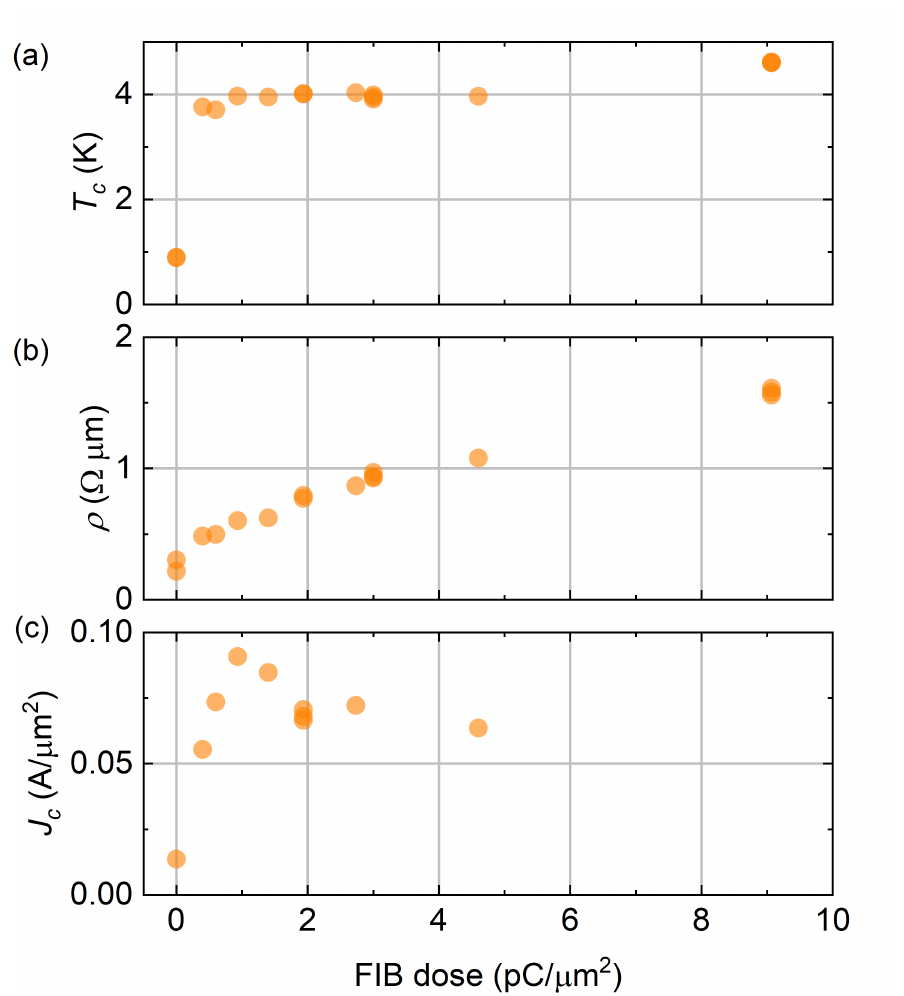
Figure 2. The effect of FIB dose on ( a ) critical temperature, ( b ) normal state resistivity, and ( c ) critical current density of the uncoated micrometer scale samples (Figure 1b). The milling caused by the FIB is taken into account in the